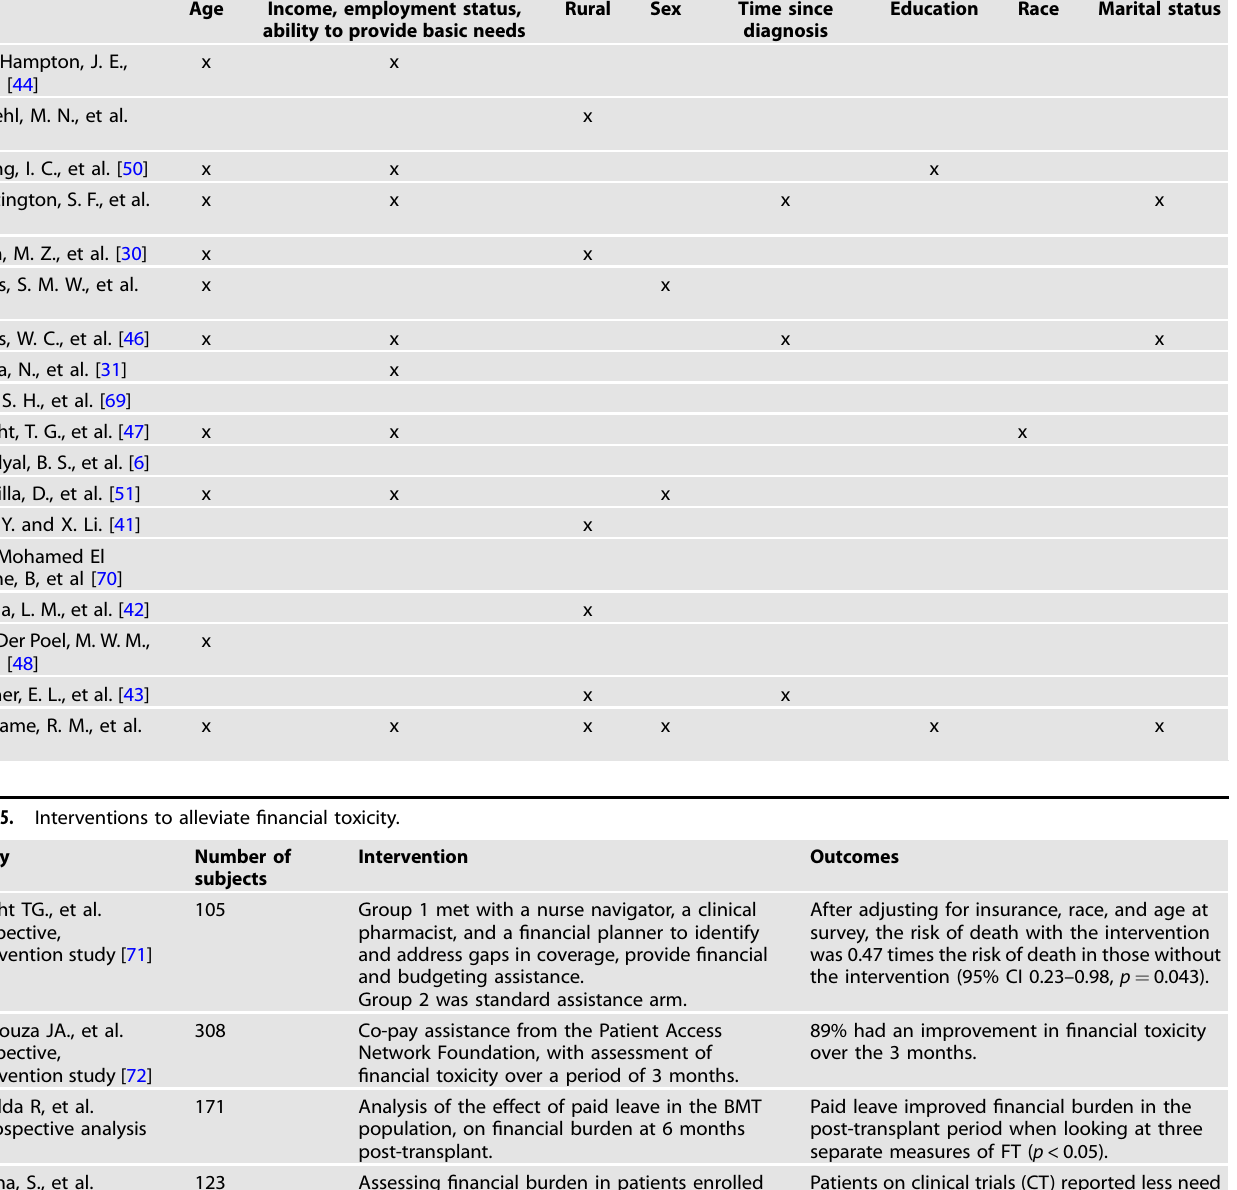
Patients on clinical trials (CT) reported less need for taking extended time off from work (22% CT vs 46% non-CT p = 0.02). Financial burden was found to be lower in the CT group but differences not statistically signi fi cant. policies were set in place.